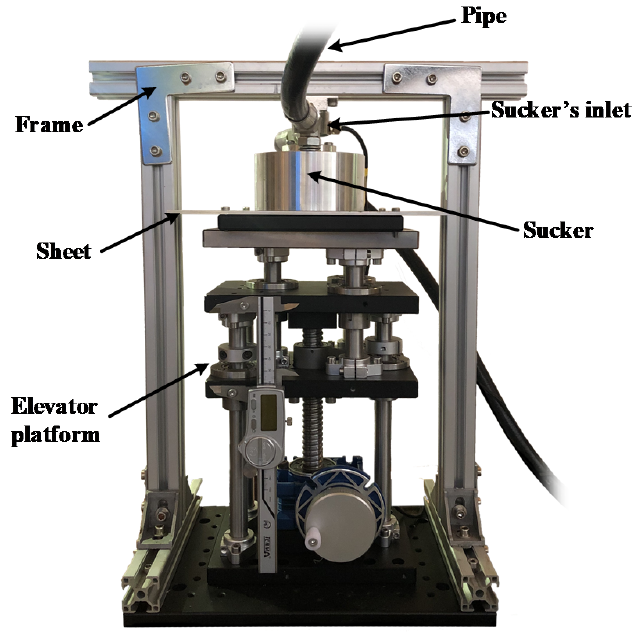
Figure 4. Force measurement apparatus.